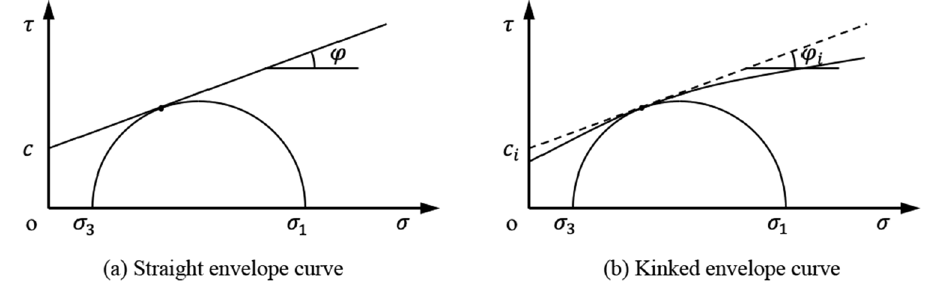
Figure 3. Relationships between the Mohr circle and the damage